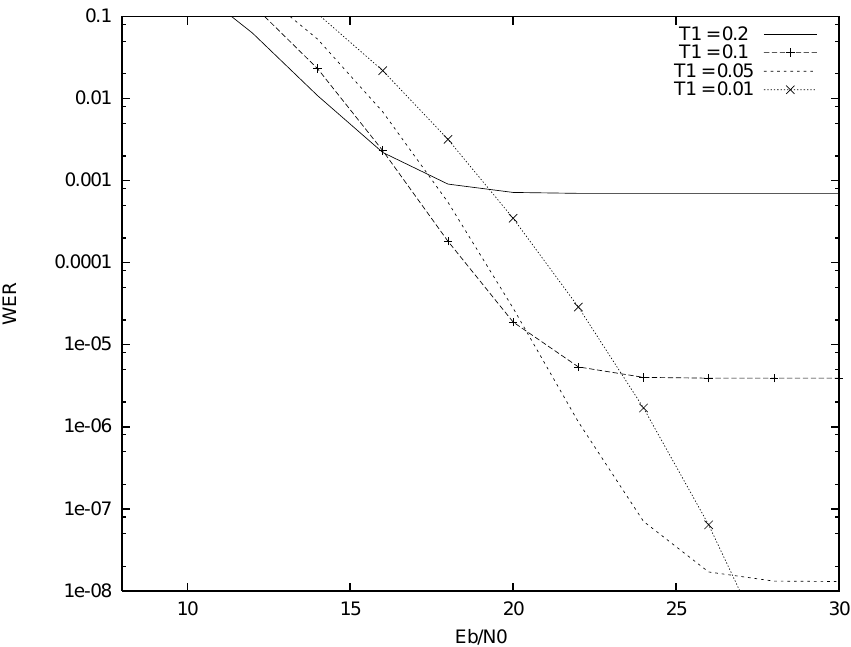
Figure 6. WER vs. E b / N 0 for truncation only with comparing a